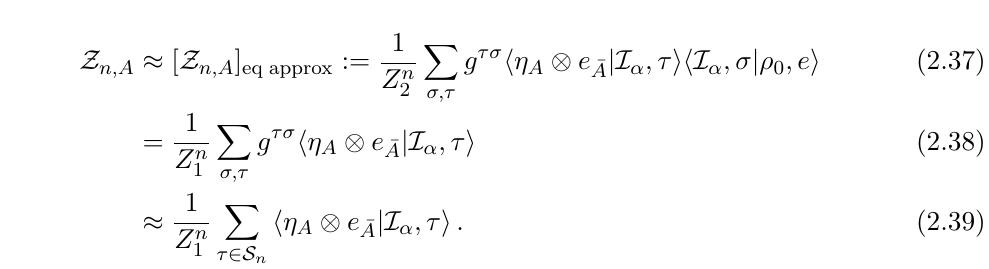
Figure 2 . (a) shows the common exterior lines of all diagrams for different terms in (2.39), and FIG. 4. Examples of non-planar diagrams corresponding to two choices of ⌧ that do not saturate FIG. 3. Examples of planar diagrams corresponding to di ↵ erent choices of planar permutations ⌧ (b) and (c) show examples of diagrams for two choices of τ , for the case n = 6 . (2.39). that saturate (2.39). find that Z ( A )